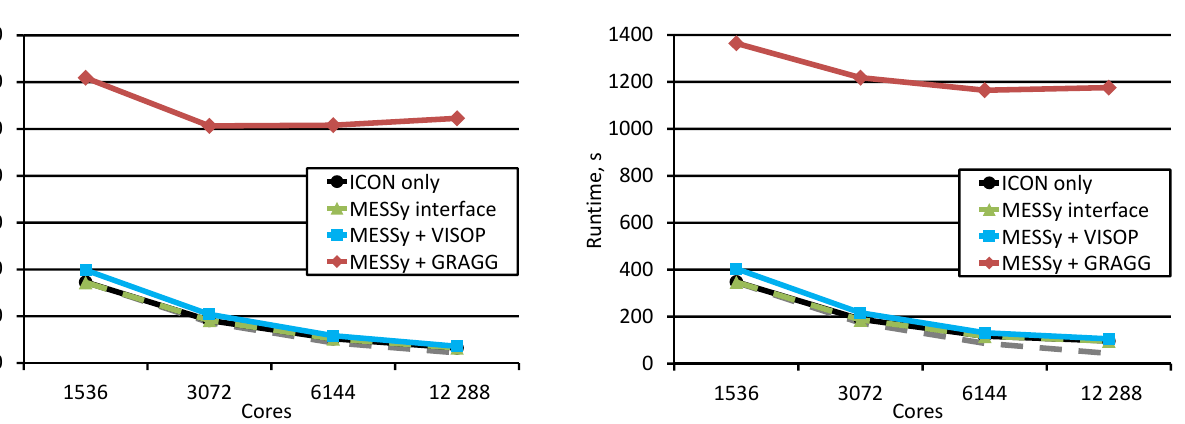
Figure 4. Runtime (s) for different test cases with deactivated out- put, measured with the internal timer “total” on 64, 128, 256, and 512 nodes (1536, 3072, 6144, and 12288 cores, respectively) of HLRE-3. The dashed grey line marks perfect scaling for “ICON only”.